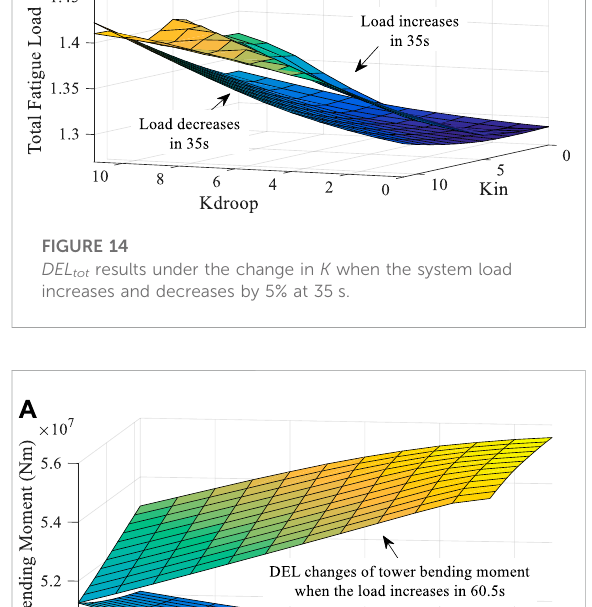
FIGURE 16 DEL Ms results under the change in K when the system load increases and decreases by 5% at 60.5